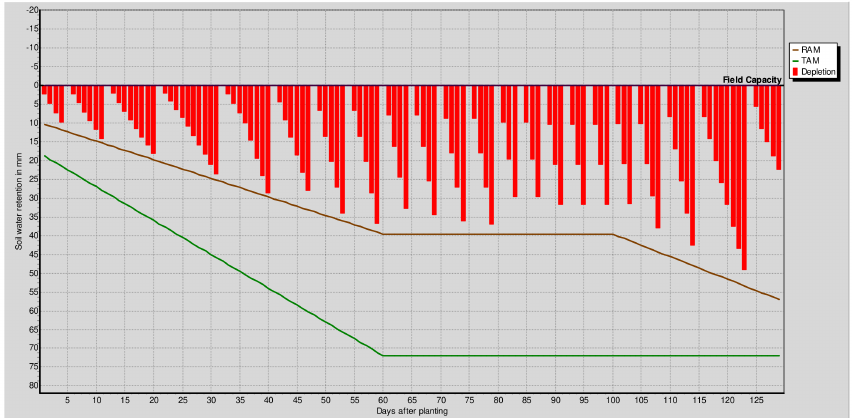
Figure 13. Irrigation schedule for wheat at site 5 ( x -axis shows days after planting and y -axis shows soil water retention in mm). TAM = total available moisture; RAM = readily available moisture.